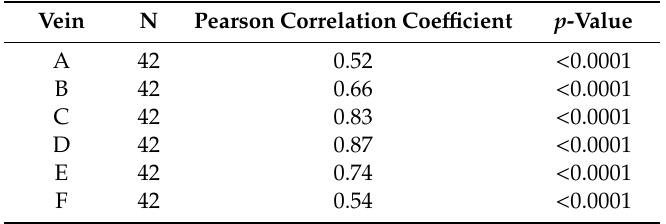
Table 3. Correlation between two independent measurements (calculated on absolute values of differences between veins of right and left D. melanogaster wings).